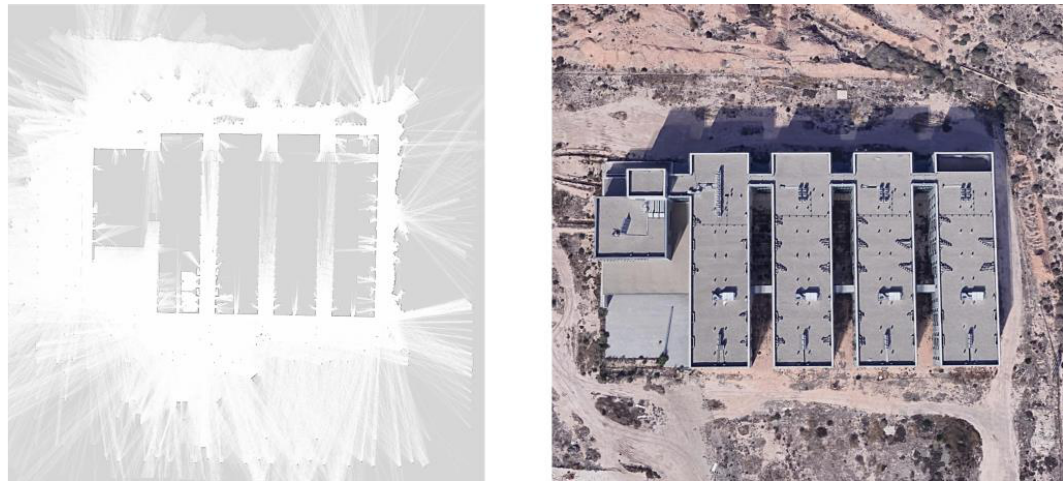
Figure 10. ( left ) Grid map of the secondary laboratory building, obtained using the architecture shown in Figure 2. ( right ) The actual building and the environment where the initial framework experiments have been carried